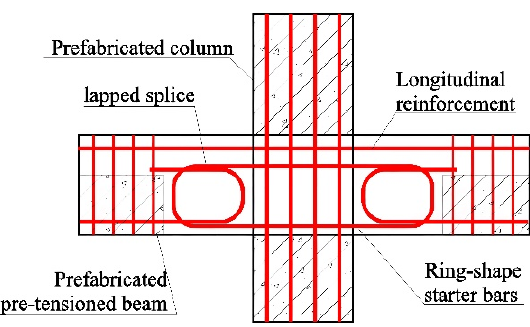
Figure 3. Ring buckle lap beam-column joint.